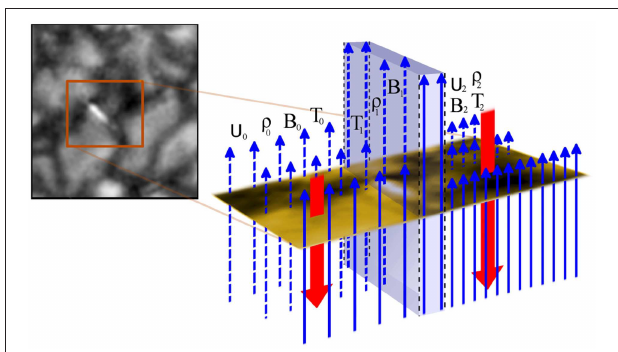
FIGURE 12 | An elongated magnetic bright point visualized as a non-stationary slab. The sketch is based on Figure 12 of Liu et al. (2018), showing TiO 7058 Å observations taken by the New Vacuum Solar Telescope, and a further development on the model featured in Zsámberger et al. (2018). Blue arrows represent the magnetic field lines, and red arrows represent flowing